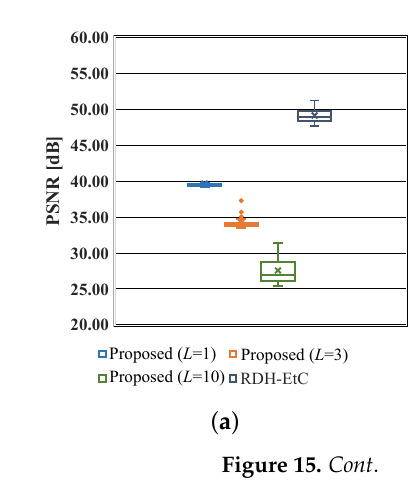
Figure 14. Marked images ( L = 10). ( a ) Kodim4; ( b ) peppar; ( c ) ihc5 (1/16); ( d ) ihc5 (original).